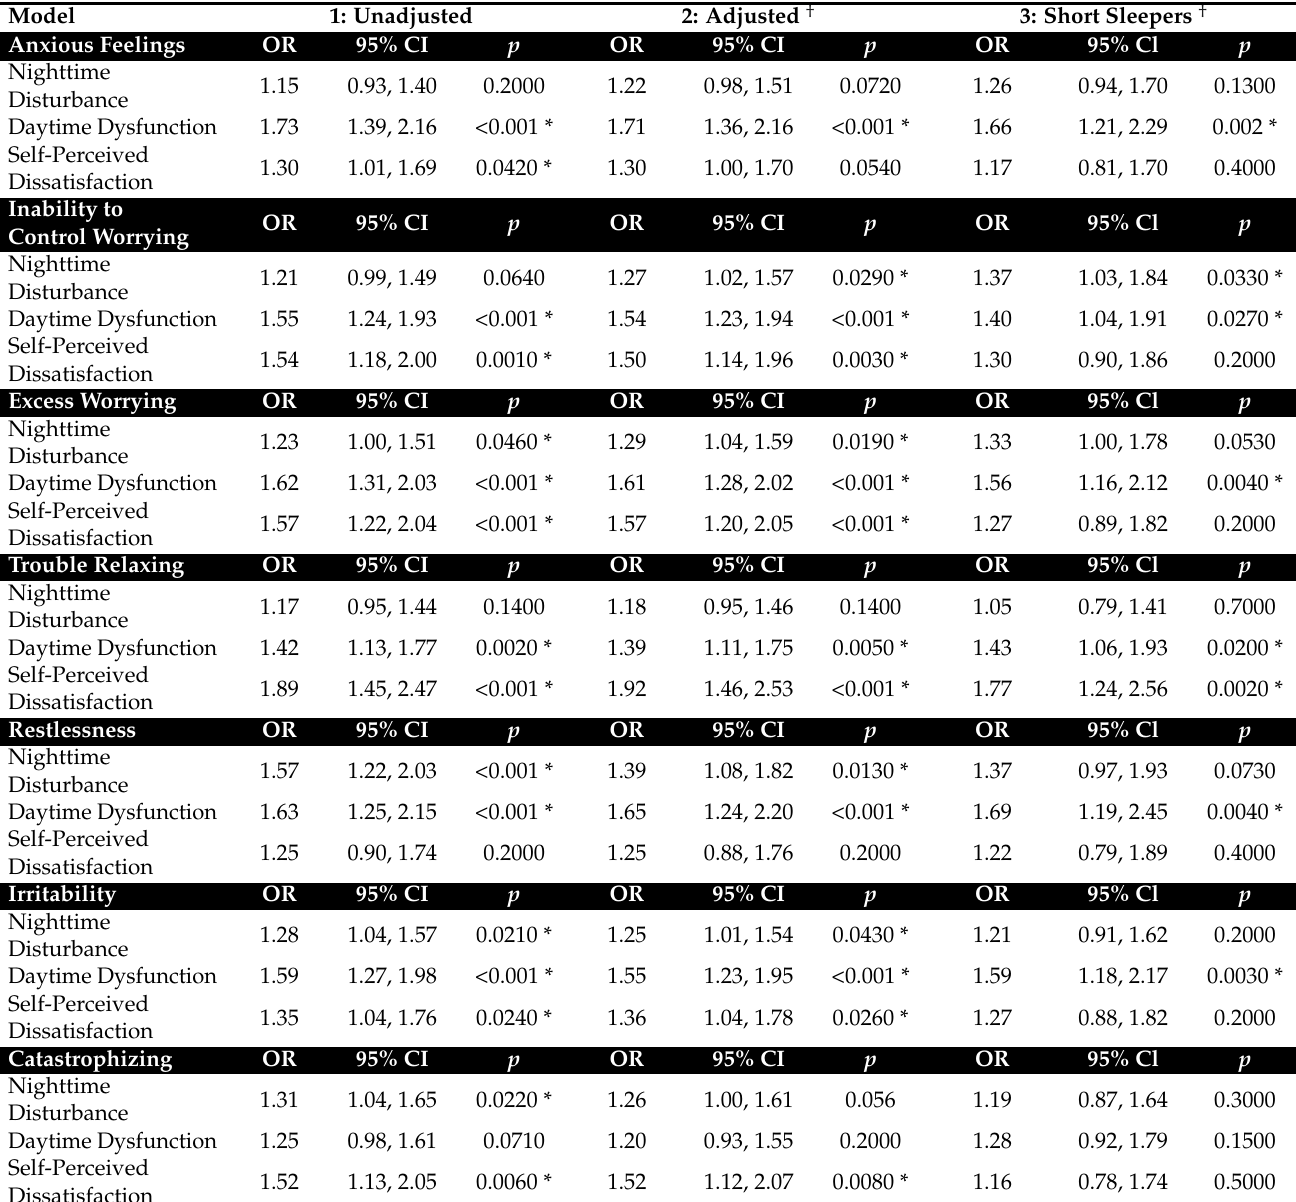
Table 3. The associations between insomnia components and symptoms of anxiety.